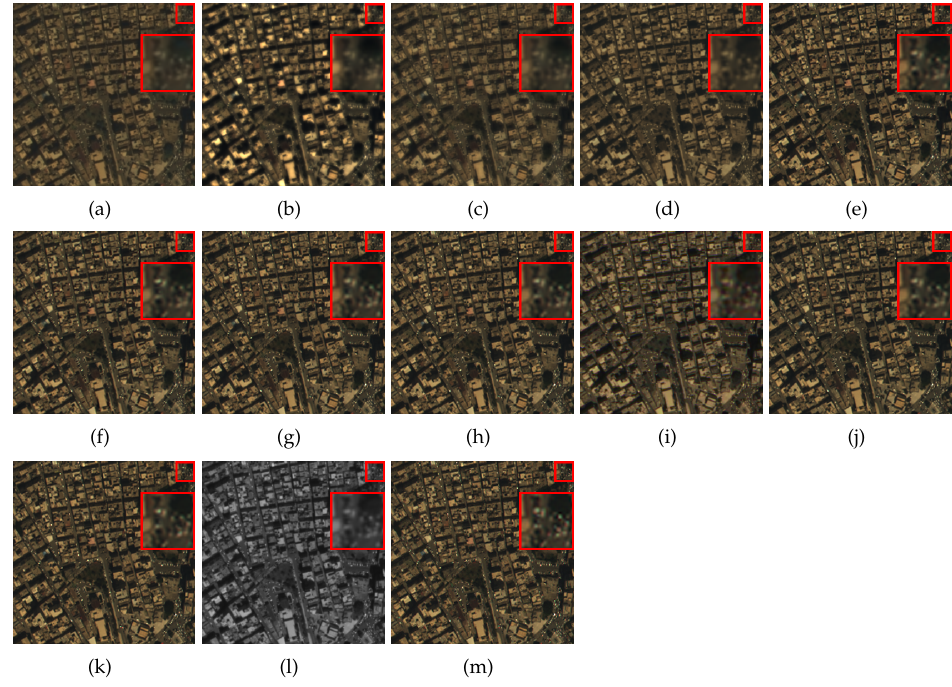
Figure 9. Qualitative comparison of MPFINet with ten counterparts on a sample from the WV3 dataset. ( a ) Brovey. ( b ) MTF_GLP_HPM. ( c ) SFIM. ( d ) CNMF. ( e ) PNN. ( f ) PANNET. ( g ) SRPPNN.